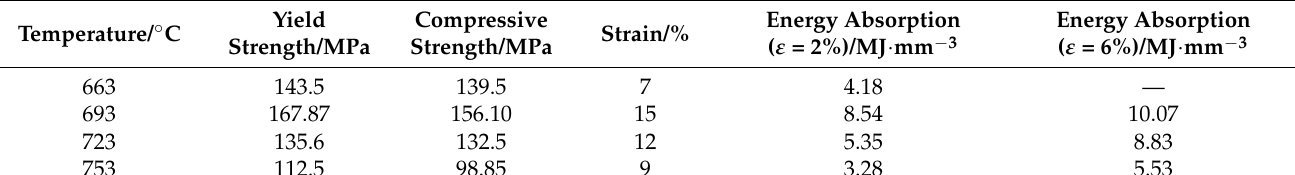
Table 3. Compressive properties of Al 2 O 3hs /AZ91D.